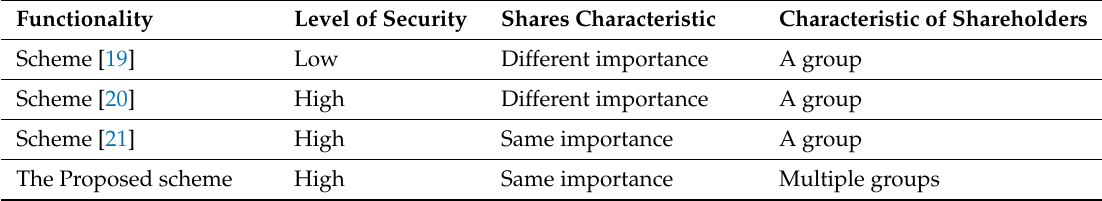
Table 2. Comparisons between proposed scheme and some existing HSIS schemes.